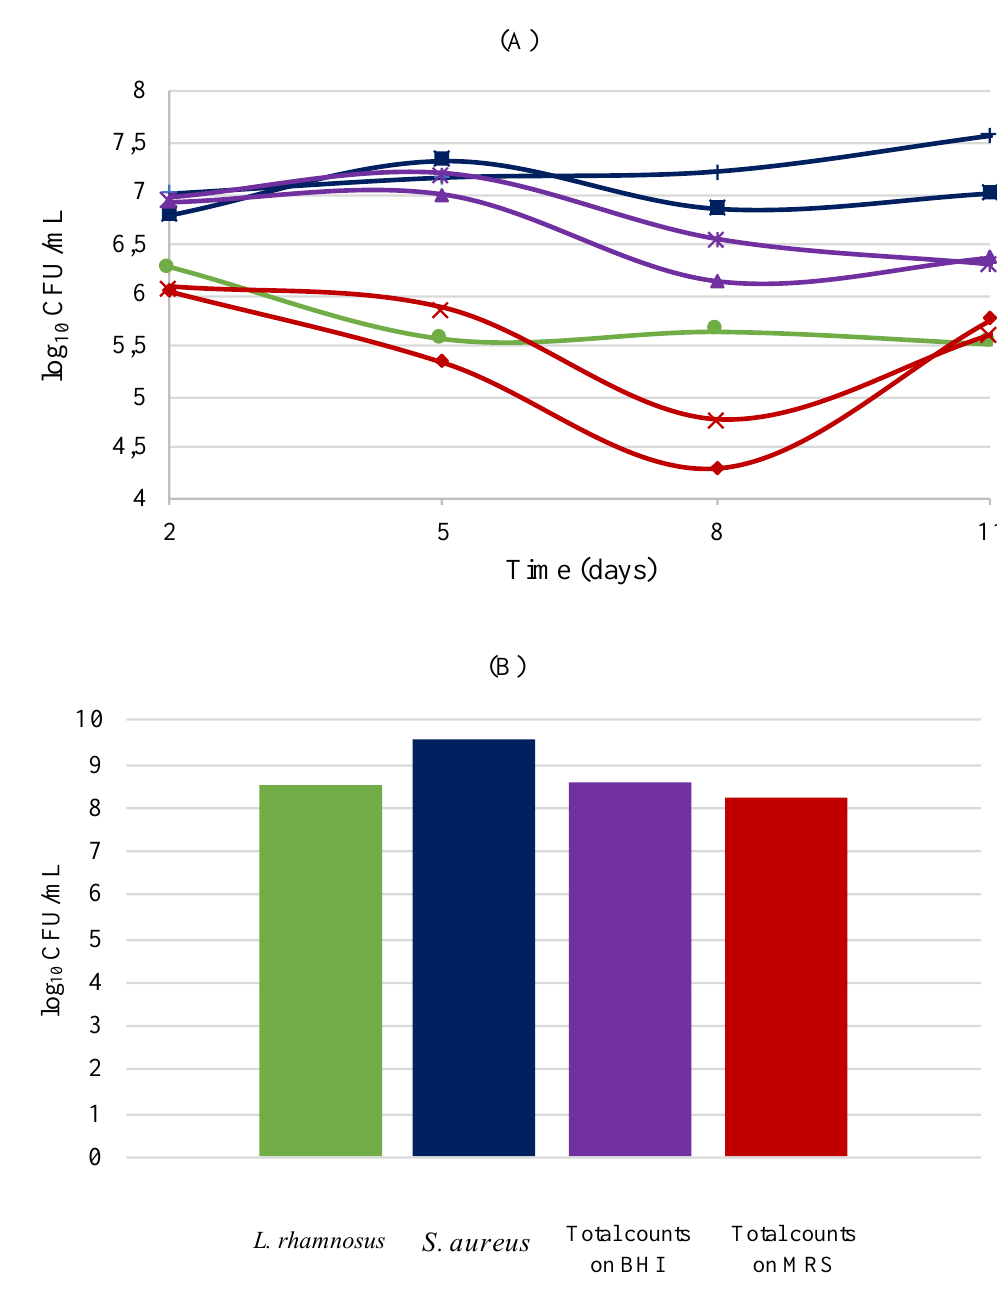
Figure 10. Bacterial counts in human skin equivalents. Counts on the skin models collected with swab ( A ): S . aureus first wound (+) S . aureus second wound ( ■ ) S . aureus plus L . rhamnosus —first wound ( ) S . aureus plus L . rhamnosus —second wound ( ) S . aureus plus L . rhamnosus —first wound ( ) S . aureus plus L . rhamnosus —second wound ( ♦ ) L . rhamnosus ( ● ). Bacterial counts after sacrificing the models ( B ).